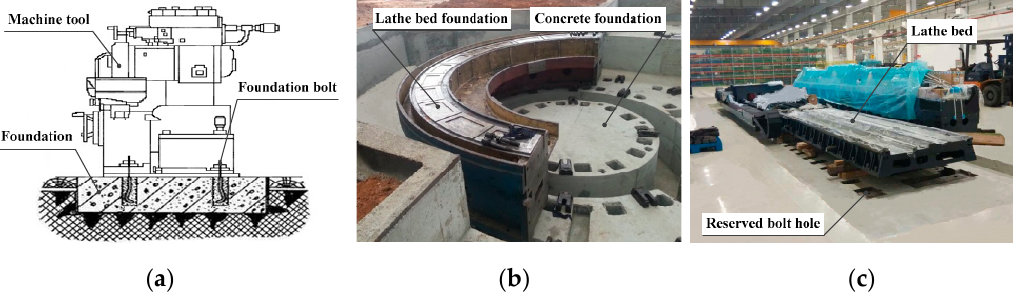
Figure 1. Conventional approach to constructing machine tool foundations: ( a ) Structure of a machine tool foundation; ( b ) a concrete machine tool foundation; ( c ) a lathe bed waiting for secondary grouting.